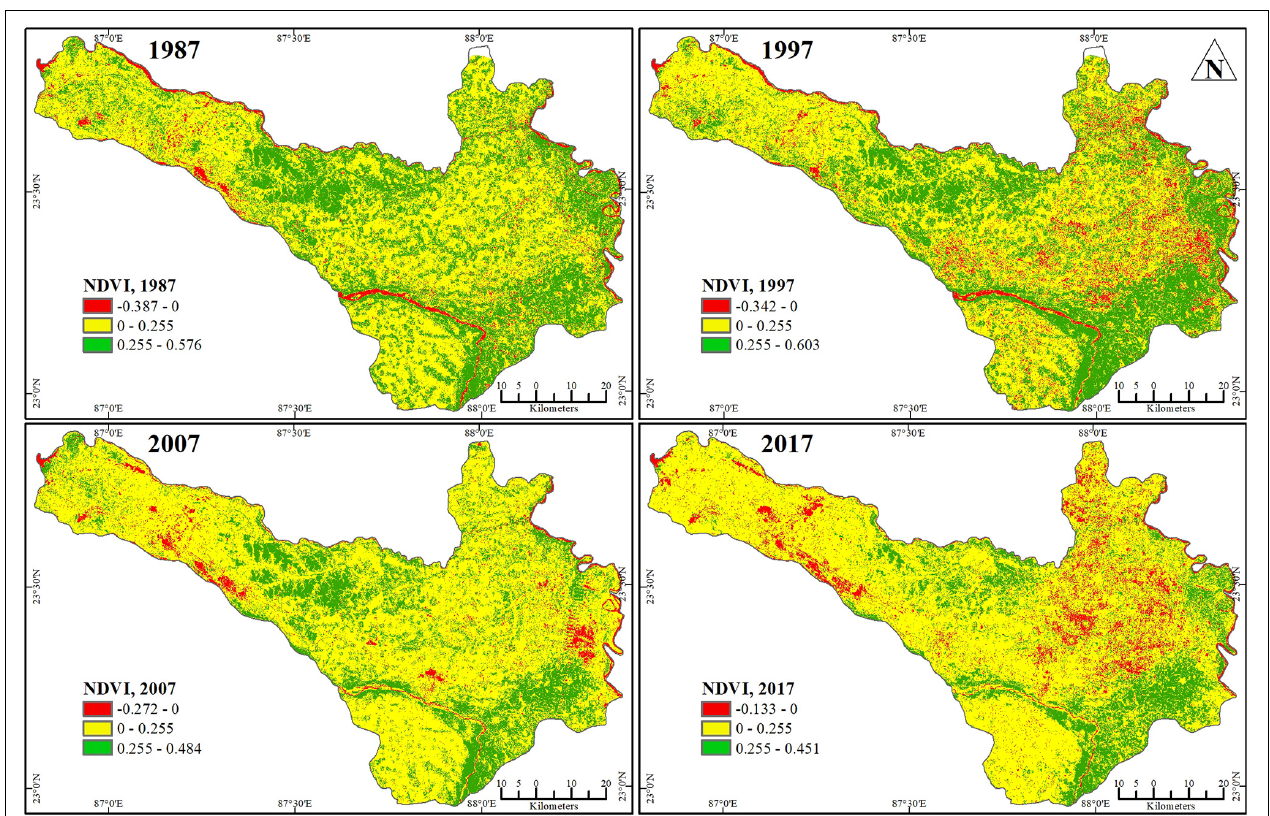
FIGURE 5 | Normalized Difference Vegetation Index (NDVI). Author, 2019. (Landsat 5 and 8 satellite imagery, USGS).